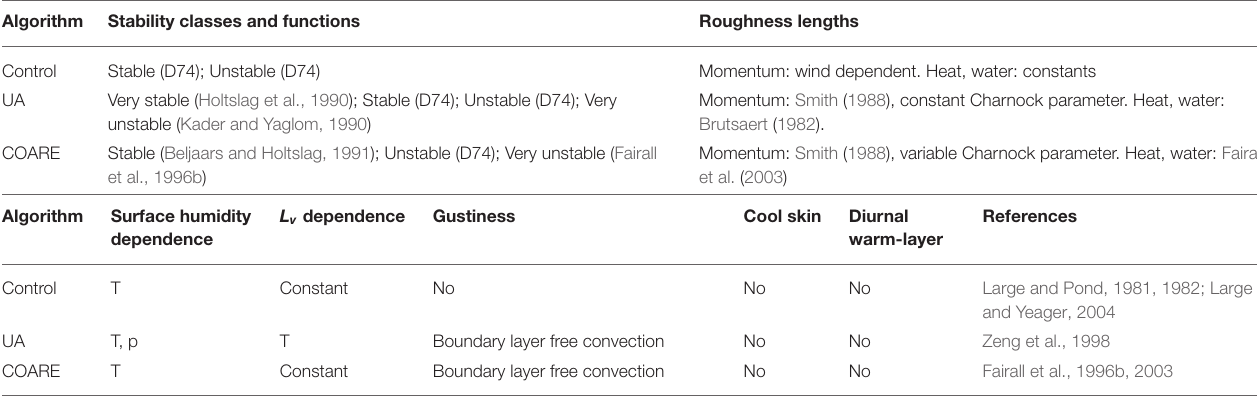
TABLE 1 | Bulk flux algorithm overview. Algorithm Stability classes and functions Roughness